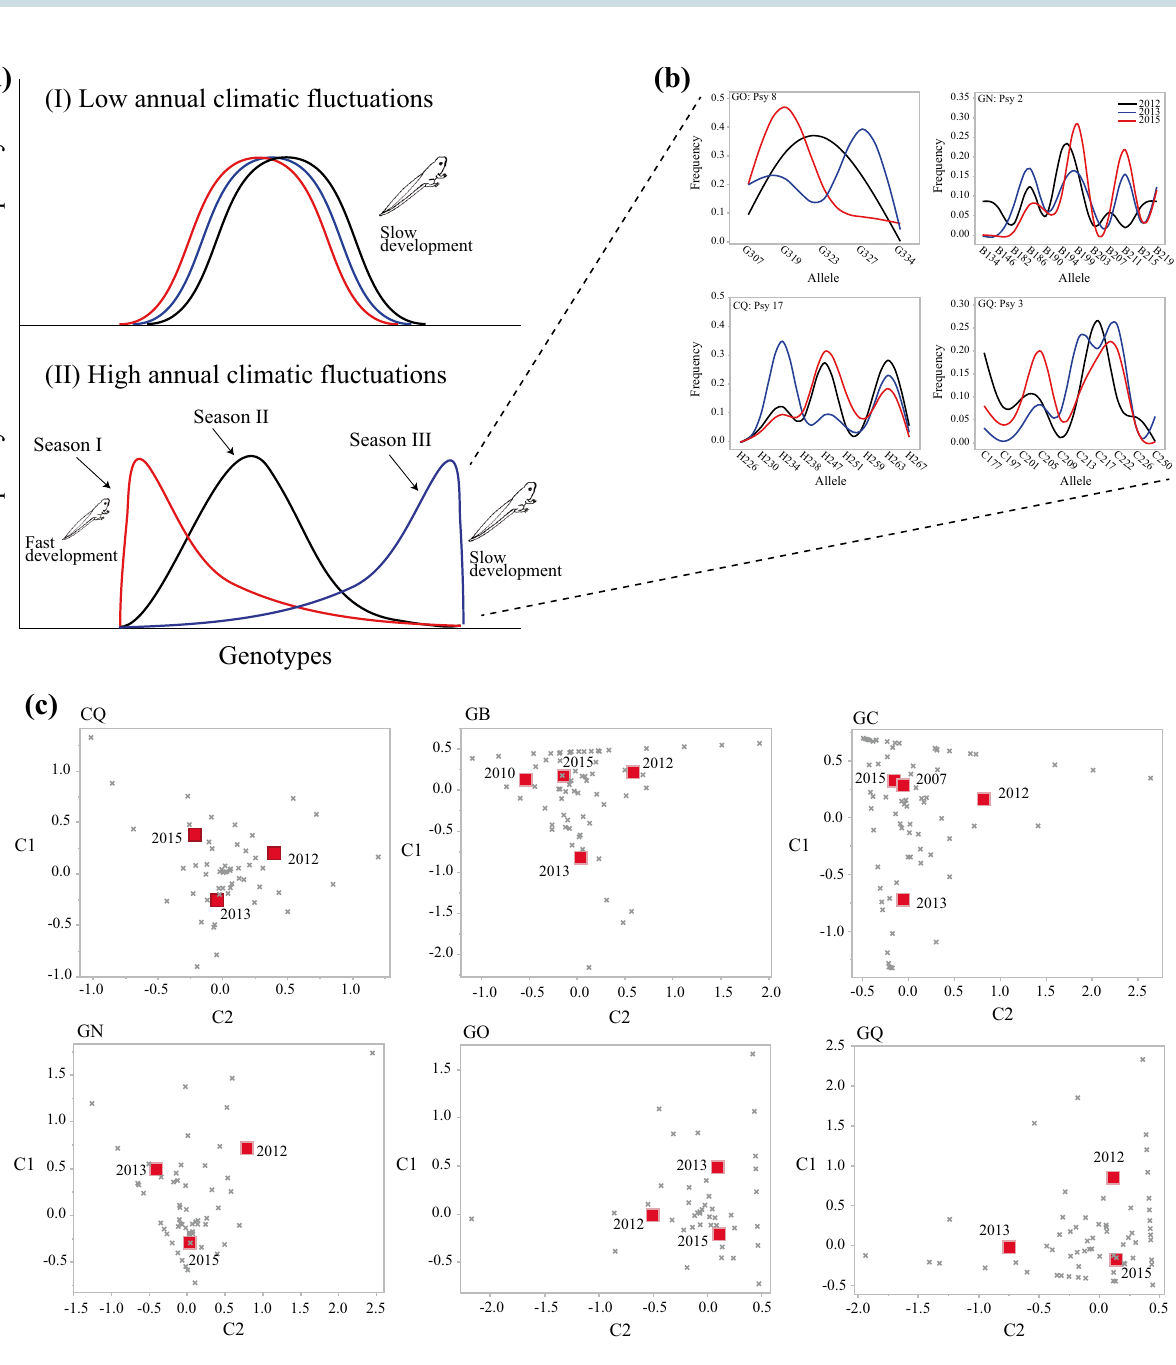
Figure 2. ( a ) The hypothesized frequency distribution of alleles in successive years in pools located in areas of low annual climatic fluctuations ( a.I ) and high annual climatic fluctuations ( a.II ). As an example of the variation in selection among successive years, the large tadpole image is associated with a long hydroperiod and slow growth rate, while the small tadpole image is associated with a short hydroperiod and fast growth rate. See text for more details. ( b ) The interannual variation in allele distribution for four loci (Psy 2, 3, 8, 17) and vernal pools (CQ, GN, GO, GQ) is provided as an example of the high annual fluctuations in the study area. ( c ) Correspondence analysis associating allele frequencies (gray crosses) and years (red squares) in six vernal pools. Pool name abbreviations were taken from Table